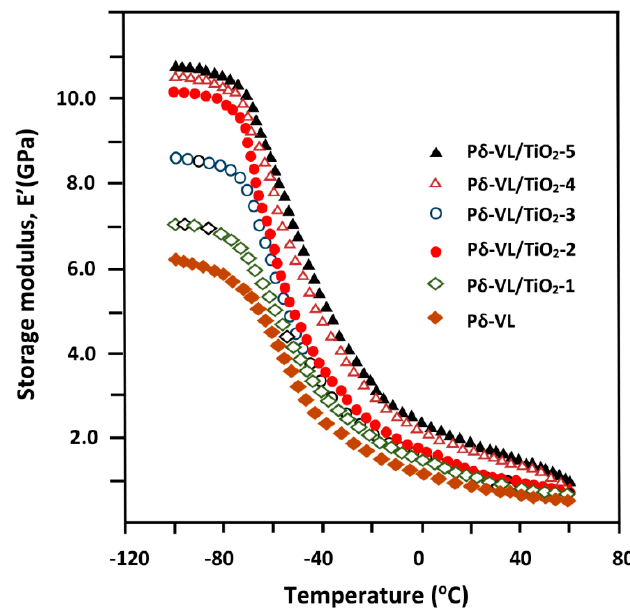
Figure 6. Variation of the storage modulus, E ′ , versus temperature for virgin P δ -VL and P δ -VL/TiO 2 nanocomposites containing different TiO 2 loads prepared by solvent casting method.